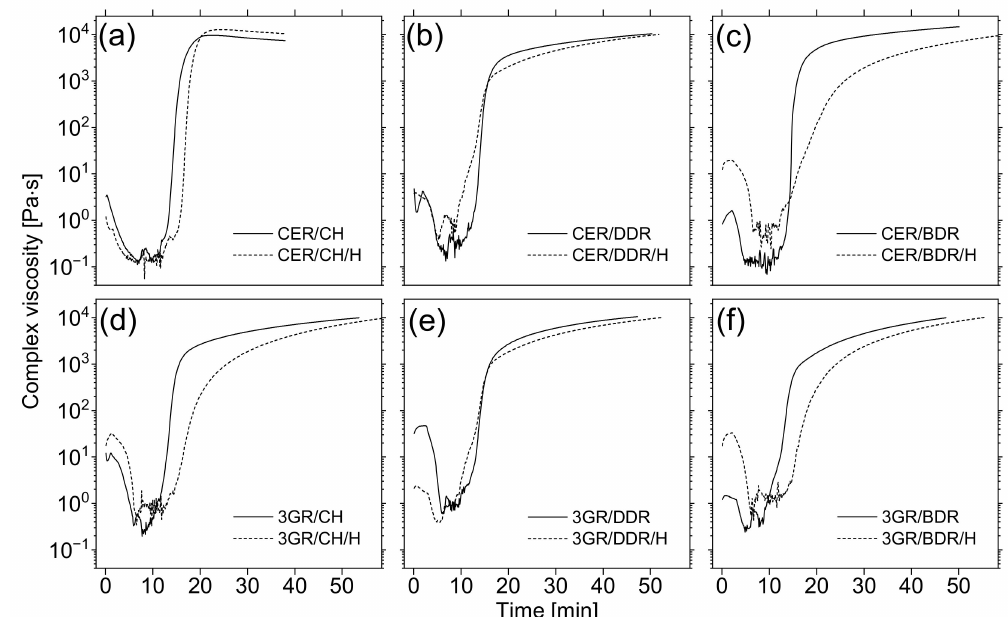
Figure 4. Rheological curves of coating composition curing processes involving heating from 90 to 200 ◦ C (heating rate 10 ◦ C/min) followed by the reaction under isothermal conditions (definitions of symbols in legends were given in Table 1). ( a – c ) CER—commercial epoxy resin; ( d – f ) 3GR—rosin-based triglycidyl ether.